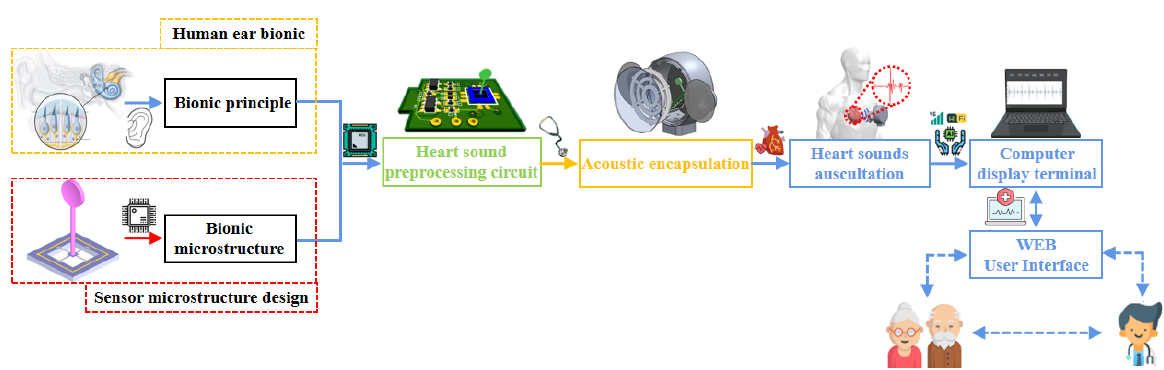
Figure 12. System’s overall design of the block diagram.